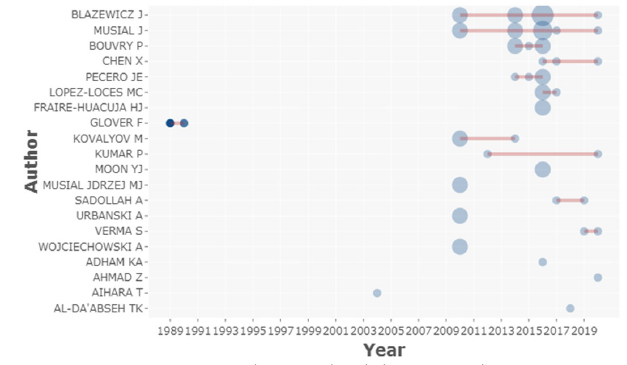
Fig. 5. Top Author Productivity Over Time